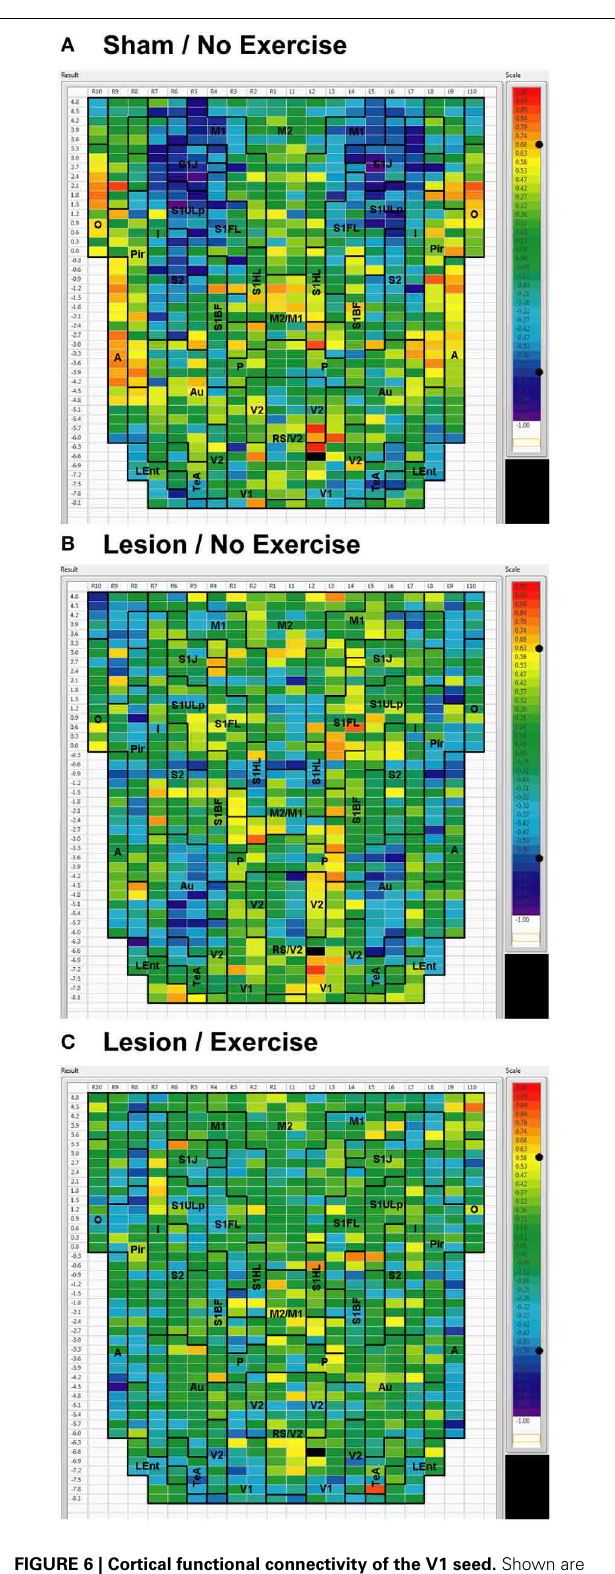
FIGURE 6 | Cortical functional connectivity of the V1 seed. Shown are animals receiving (A) sham treatment, (B) lesion without exercise, and (C) lesion with exercise. The seed is placed in the left primary visual cortex at